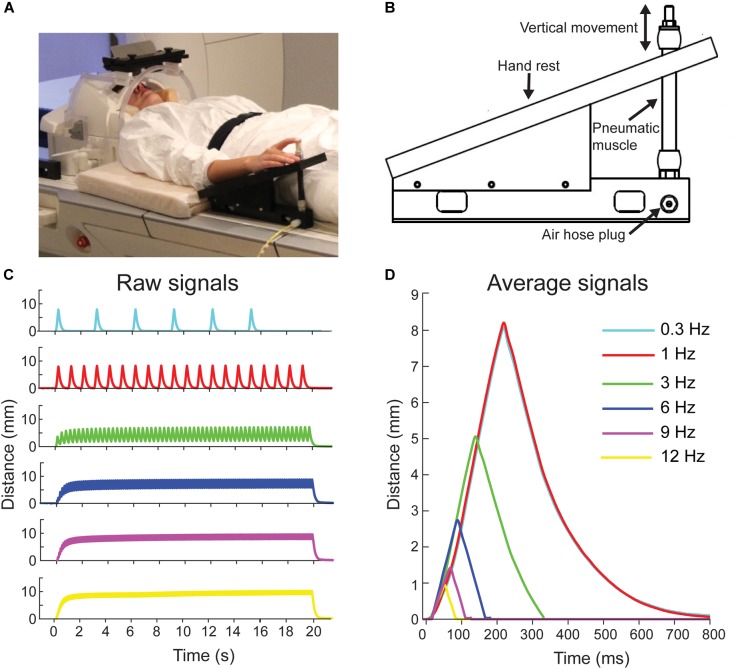
Pneumatic movement actuator and movement properties. (A) Participant is lying on the fMRI with her right index finger attached to the movement actuator. Written consent was obtained from the participant for the photograph to be used in a publication. (B) Schematic of the pneumatic-movement actuator. (C) Finger position for a one 20-s stimulation block at the different movement frequencies. (D) Average finger positions for the movement frequencies across three blocks. Color codes are the same in all panels.